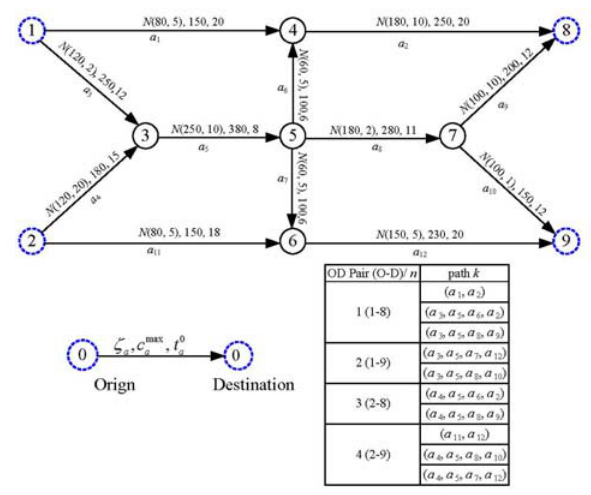
Fig. 1 Single-commodity network for computational experiment Versus different transportation time reliabilities confidence level vectors ( γ ) and different required transportation time vectors ( T ), several runs of the HIA (5000 cycles in Reliability_Check ( v ), 30 population size, 1000 generations, 0.1 crossover probability and 0.3 mutation probability in GA) show the optimal solutions and the objective function values in Table 1.